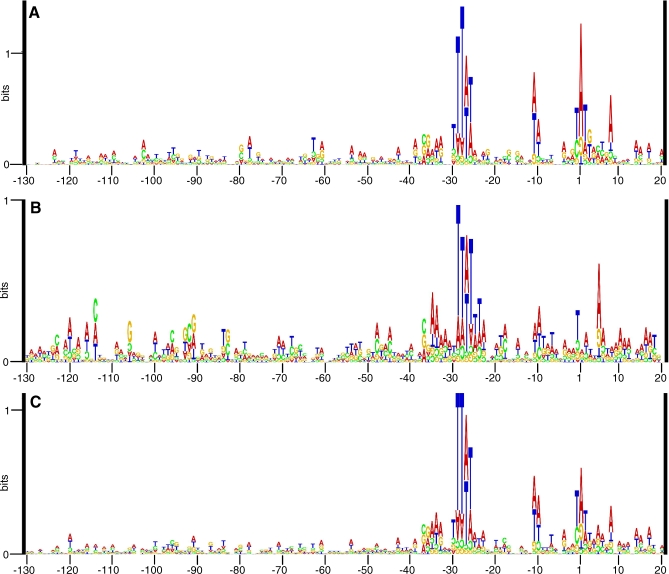
Basal Promoter Elements Identified Upstream of 63 Haloarchaeal GenesThe sequences from −130 to +20 around the experimentally determined 5′-ends of haloarchaeal transcripts (Tables 1 and 2) were retrieved from databases. Sequence logos were constructed with the program “RNA structure logo” [29]. For all logos, the height of the upright letters corresponds to the degree of conservation of that nucleotide at the respective site, measured in bits. The upside down letters indicate that the occurrence of the respective nucleotide is lower than expected in random sequences of the same GC content, and the height corresponds to the degree of underrepresentation.(A) Comparison of all 37 genes of H. salinarum (Table 1).(B) Comparison of all 26 genes of H. volcanii (Table 2).(C) Comparison of all 63 haloarchaeal genes (Tables 1 and 2).